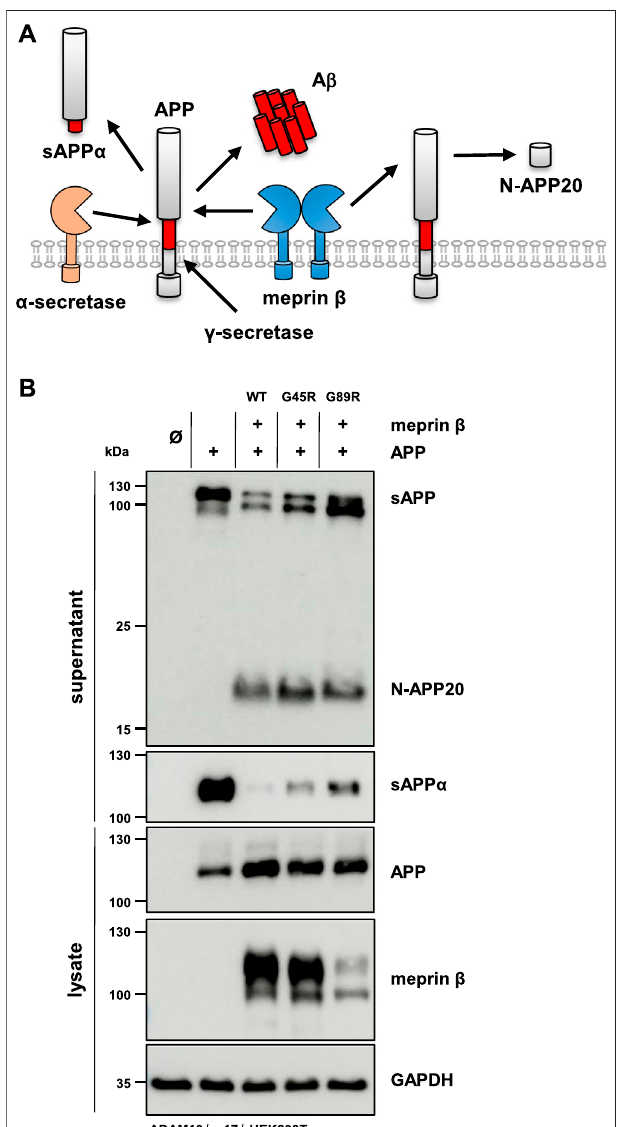
FIGURE 5 | APP processing shedding by the meprin β variants G45R and G89R. (A) APP is cleaved by meprin β in two distinct ways. On the one hand, non-amyloidogenic N-APP fragments are produced, and on the other hand, meprin β acts as a β -secretase, competing with α -secretase cleavage at the cell surface. (B) ADAM10 − / − ; 17 − / − HEK293T cells were transiently transfected with a control plasmid (Ø), APP alone, and together withoneoftheindicatedmeprin β variants.Celllysatesandsupernatantswere analyzed by immunoblotting using an anti-Flag antibody for meprin β and speci fi c APP antibodies (N-APP: 22C11, sAPP α : 6E10, and total APP in lysates: CT15). GAPDH served as the loading control. Western blot quanti fi cation ofgeneratedN-APP and sAPP α from threebiologic replicates